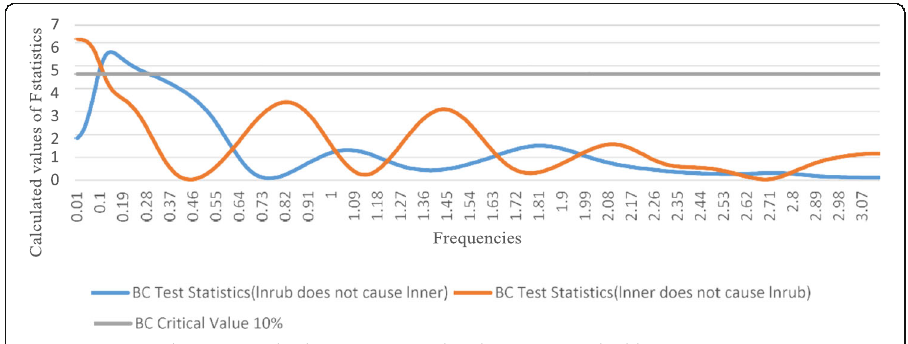
Fig. 7 Frequency domain causality between nominal exchange rate and rubber price